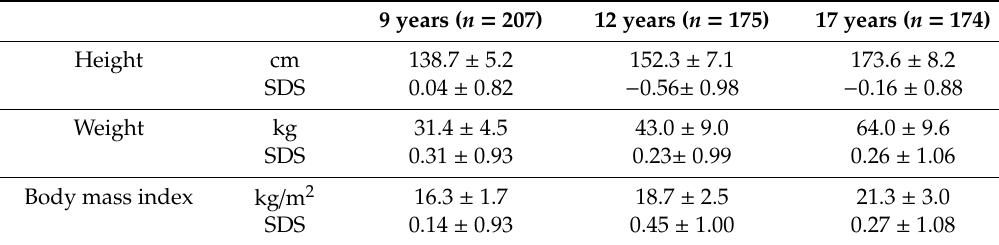
in Table 2. The mean ( ± SD) standard deviation score for body mass index (weight(kg) / height(m) 2 ) was 0.14 ( ± 0.93), 0.45 ( ± 1.00), and 0.27 ( ± 1.08) at the ages of 9, 12, and 17 years, respectively. Table 2. Characteristics of participants.